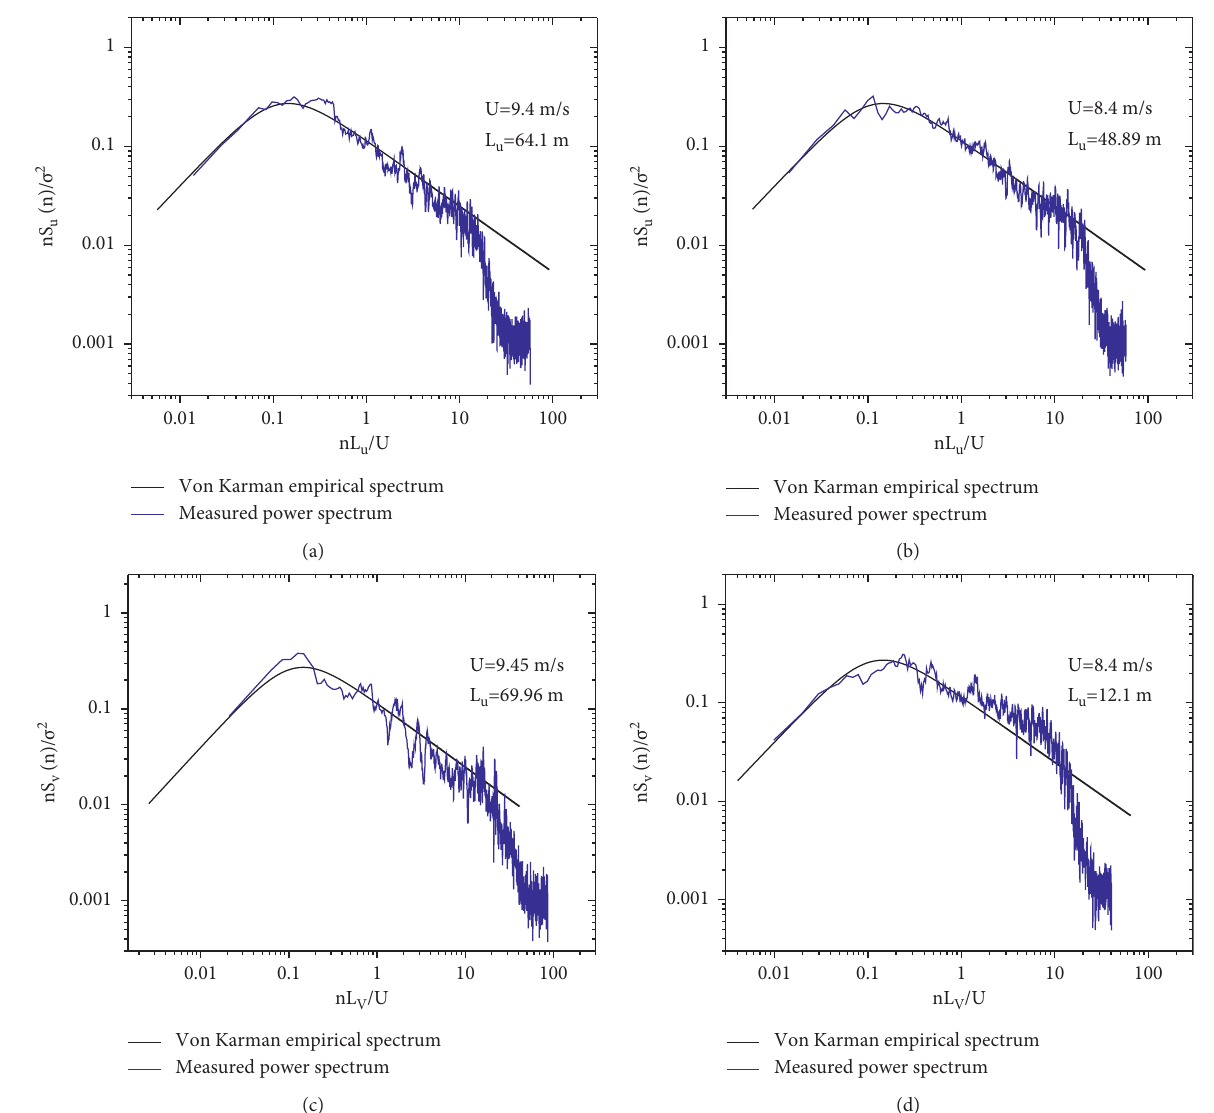
Figure 5: Power spectrum of fluctuating wind speed. (a) Measuring point 1, longitudinal. (b) Measuring point 2, longitudinal. (c) Measuring point 1, transverse. (d) Measuring point 2,